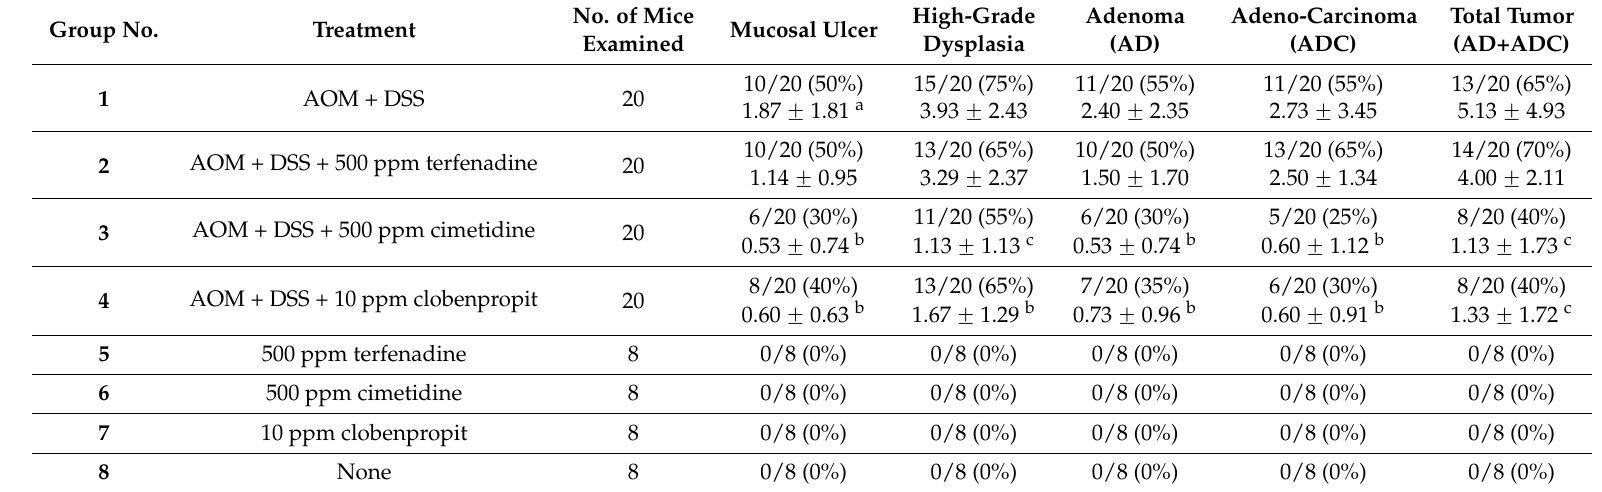
Table 1. Incidences and multiplicities of colonic lesions in all groups (18-week experiment). Group No.